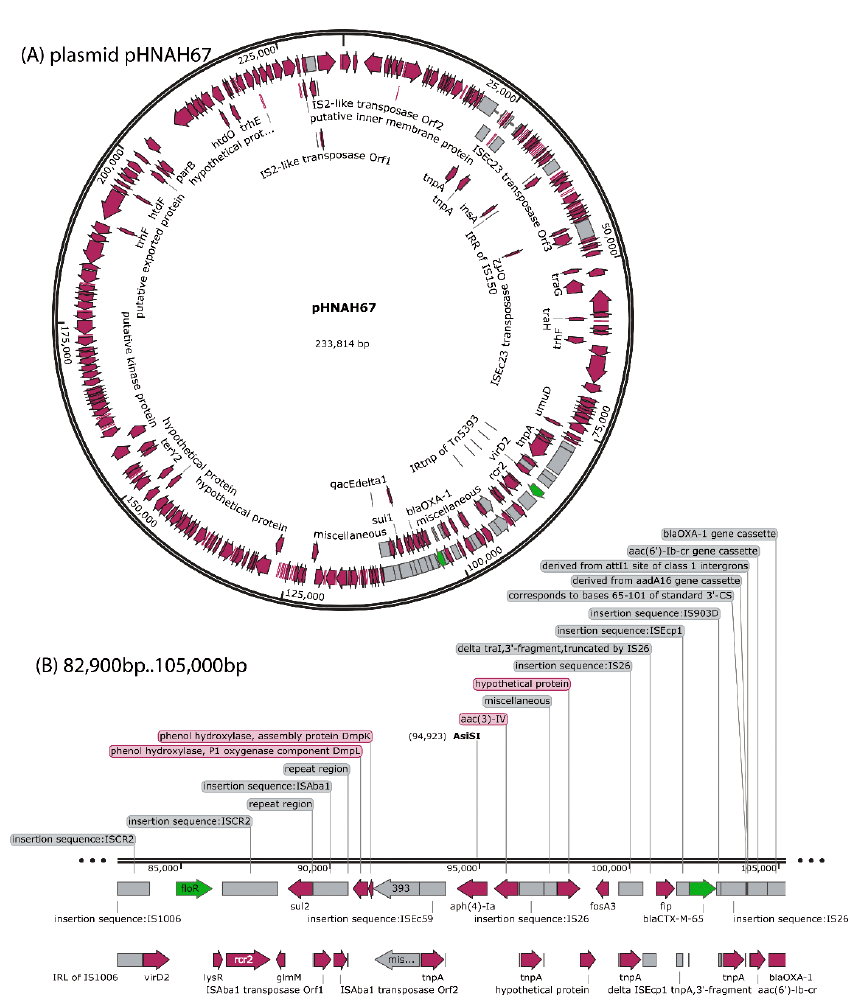
Figure 1. Gene map of lncHI2 plasmid pHNAH67. ( A ) Full annotated plasmid map. ( B ) Partial map bp 82,900 to 105,000 indicating the positions of ARG subtypes floR , sul2 , aph(4)-Ia , acc(3)-IV , fosA3 , bla CTX-M-65 , aac(6 ′ )-lb-cr , bla OXA-1 , catB3 , arr3, and sul1 .